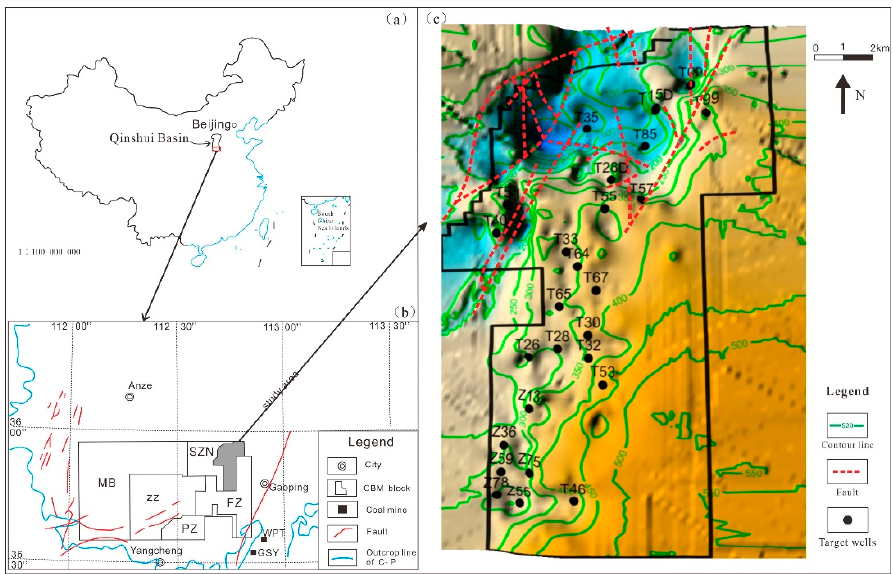
Figure 6. Location of the sampling and study area ( a ) Location of the study area in China; ( b ) The study area, showing CBM blocks in the southern Qinshui basin; ( c ) Structure outline of the study area and distribution map of maximum gas production in CBM wells.